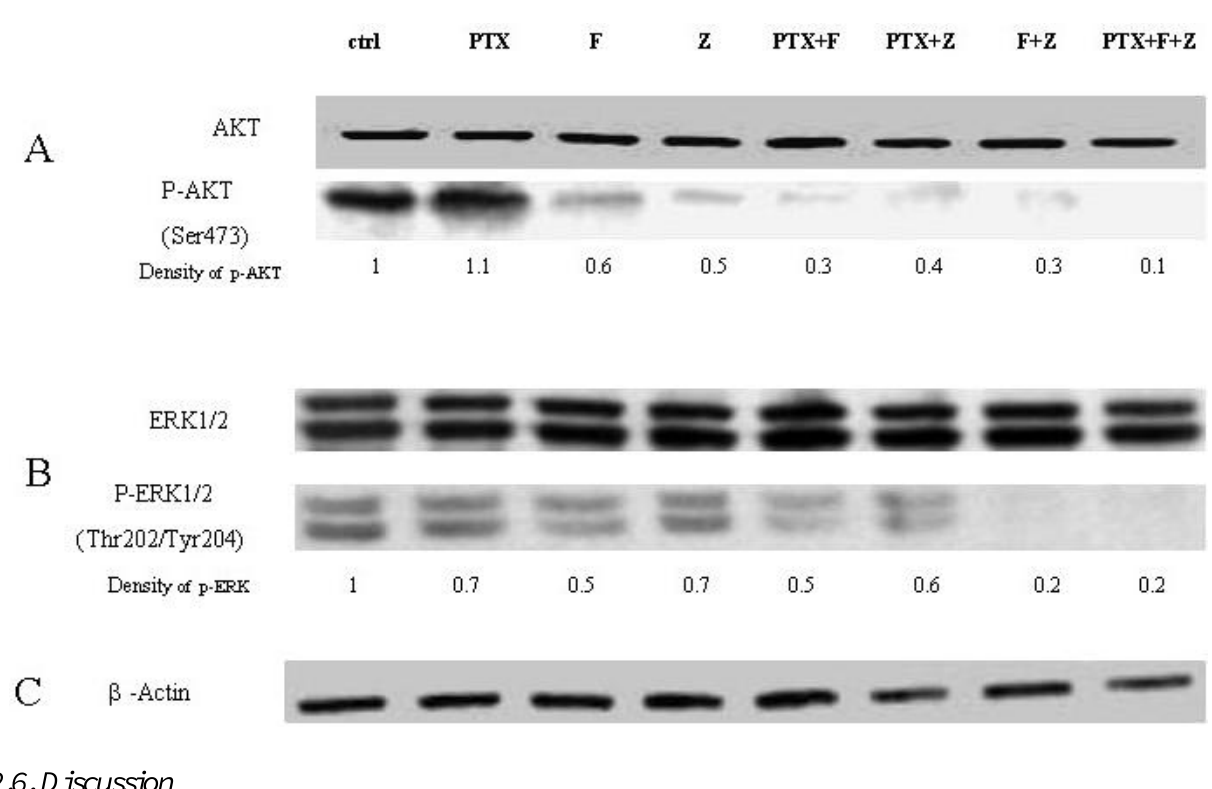
Figure 6. Inhibition of phosphorylation of AKT and ERK1/2 by paclitaxel (PTX), fluvastatin (F), zoledronic acid (Z) and their combinations. Data show that all combinations result in reduced phosphorylation of AKT (A) and ERK1/2 (B); the most effective combination appears to be paclitaxel + fluvastatin + zoledronic acid. β-actin is used as a loading control